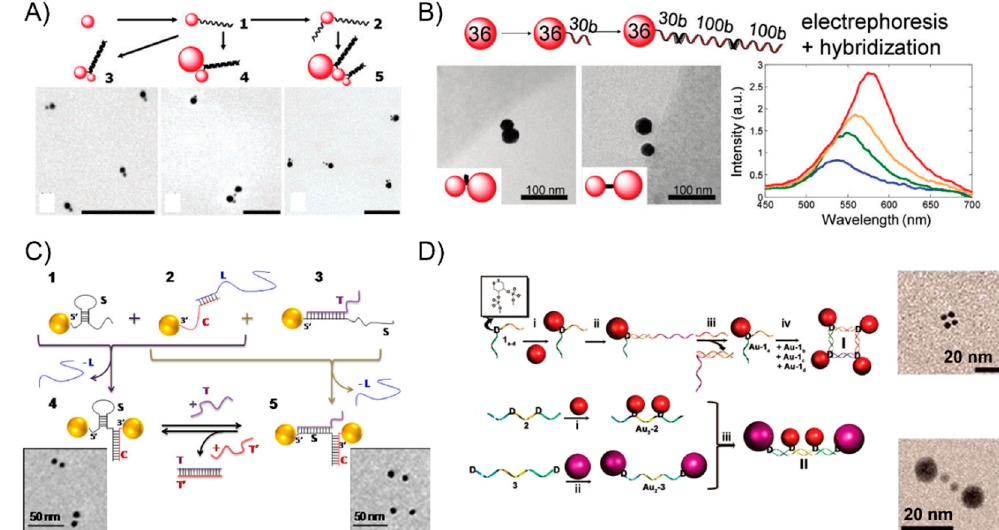
Figure 1. The DNA-linker-guided AuNP nanoarchitectures. ( A ) The AuNPs dimer and trimer with nanometer spacings by hybridizing mono-conjugated DNA-particle building blocks. An 8 nm AuNP was functionalized with a single 100-base single-stranded 5’ thiolated DNA molecule (building blocks 1 ) and sequentially functionalized with a 5’ thiolated 50 base single-stranded DNA molecule to yield building block 2 . The hybridization of building block 1 or building block 2 with 5-nm and 18-nm diameter AuNPs monofunctionalized with the 3’ thiolated complementary strand yielded structures 3 , 4 , and 5 ( B ) Symmetric or asymmetric high purity AuNP dimers with substantially scattered cross-sections and plasmon coupling using either 50-bp (base pair) or 30-bp DNA linkers perpendicular to (or parallel to) the dimer axis; the distance between the dimer can be tuned to be as short as 7 nm. ( C ) Dynamic DNA-AuNP dimers linked by a single stem-loop containing a DNA sequence. Sequence S is designed to contain a 10 bp stem-loop which opens when hybridizing a T single-strand, and the 100 bases-long S sequence can hybridize a complementary C DNA molecule that is over 50 bp. Structures 1 , 2 , and 3 in Figure 1C are obtained via the electrophoresis separation of 8-nm AuNPs linked to a single thiolated S , C or S + T DNA molecule. The closed 4 and open 5 dimers are obtained by hybridizing structures 1 + 2 and 2 + 3 , respectively. ( D ) The formation of well-defined AuNP squares and rectangles via stably anchoring one or more AuNPs to either the interior or terminal position in the DNA strand, forming well-defined AuNP squares and rectangles using a cyclic disulfide: (i), AuNPs modified internally with cyclic disulfide D , (ii) the addition of the extension strand, (iii) the electrophoresis purification of the DNA-AuNP conjugate by a displacement strand, (iv) tetramer structure I attained by annealing four such monoconjugates Au-1 a-d . Similar, the linear tetrameric structure II is also prepared by the selective functionalization of D -modified strands 2 (step i) and 3 (step ii) with two different sizes of nanoparticles. This strategy has the potential to enable the construction of any number of discrete DNA-AuNP conjugates. Reproduced with permission from Reference